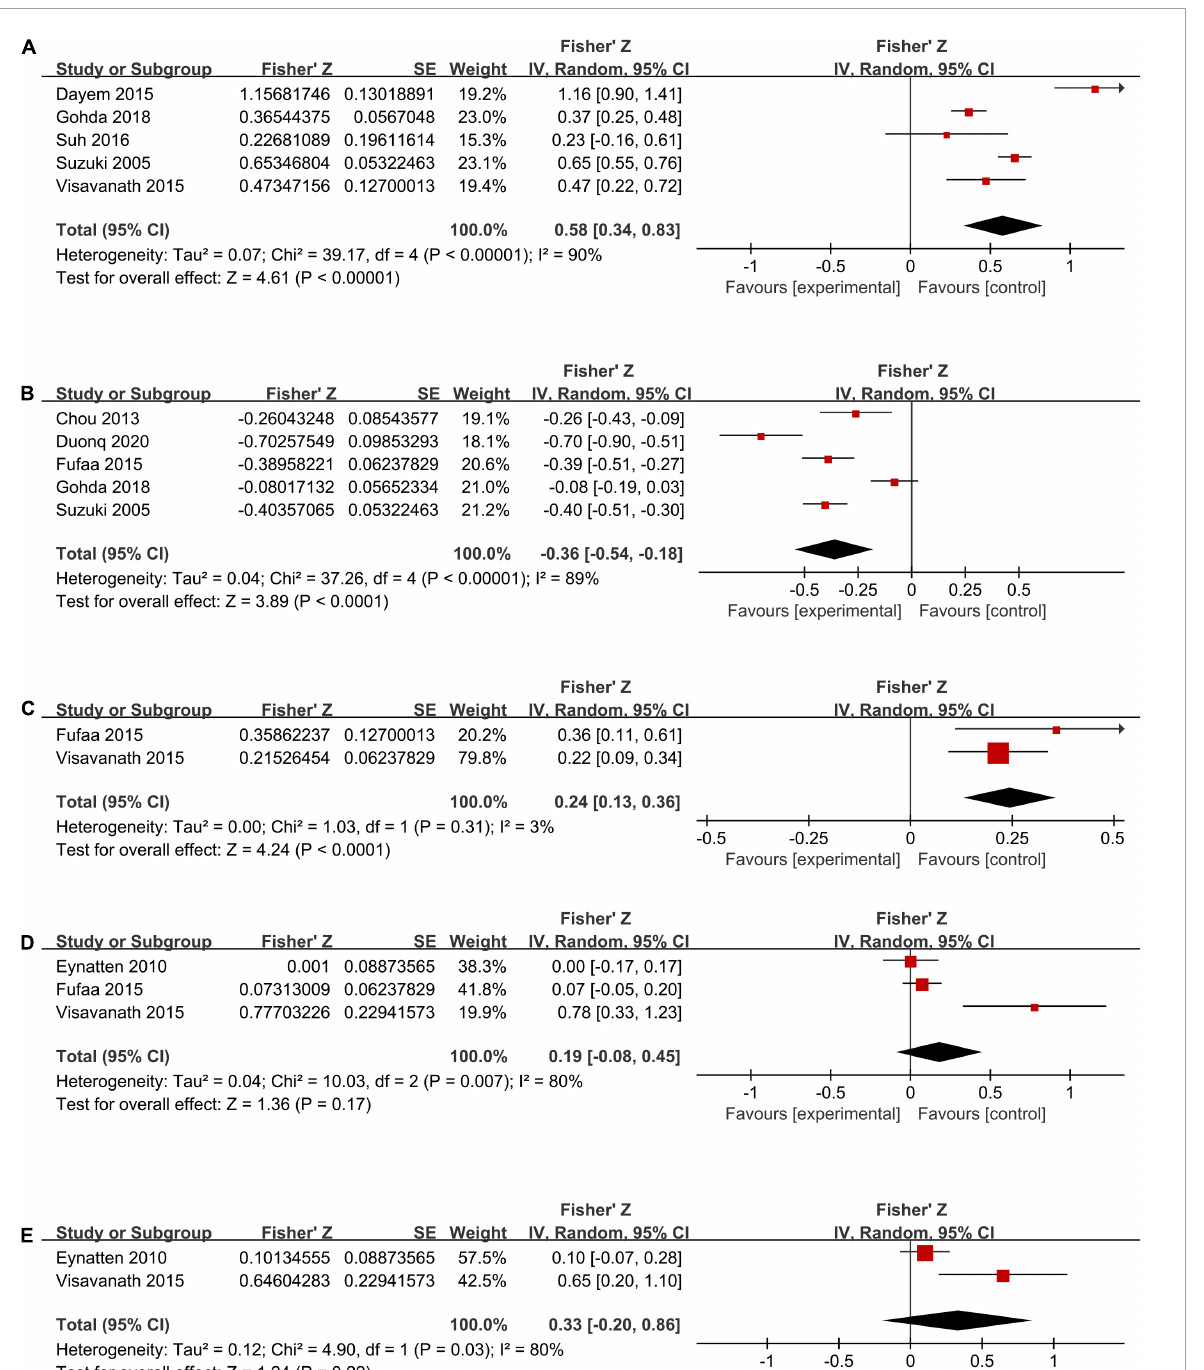
FIGURE4 Forest plots of correlation analysis between u-LFABP values and different clinical index of ACR (A) , eGFR (B) , SBP (C) , HbA1c (D) , FPG (E) .